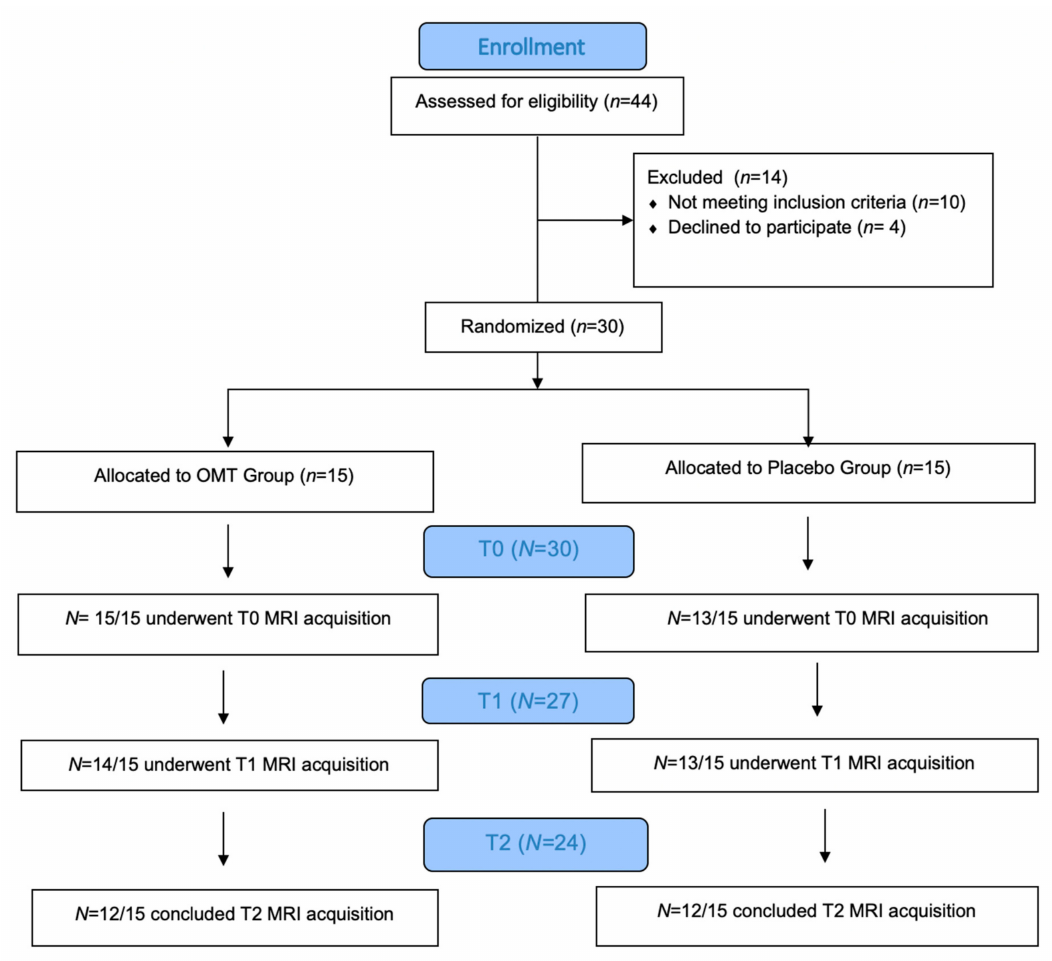
Figure 1. Flow Chart of the